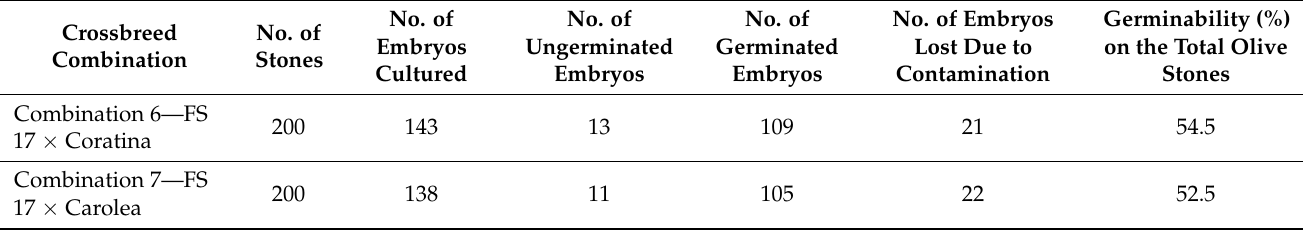
Figure 2. Germination percentages of in vitro isolated olive embryos on the two media tested com- pared to the germinability of directly sown olive stones from the 5 different cross combinations of the 2017 season.